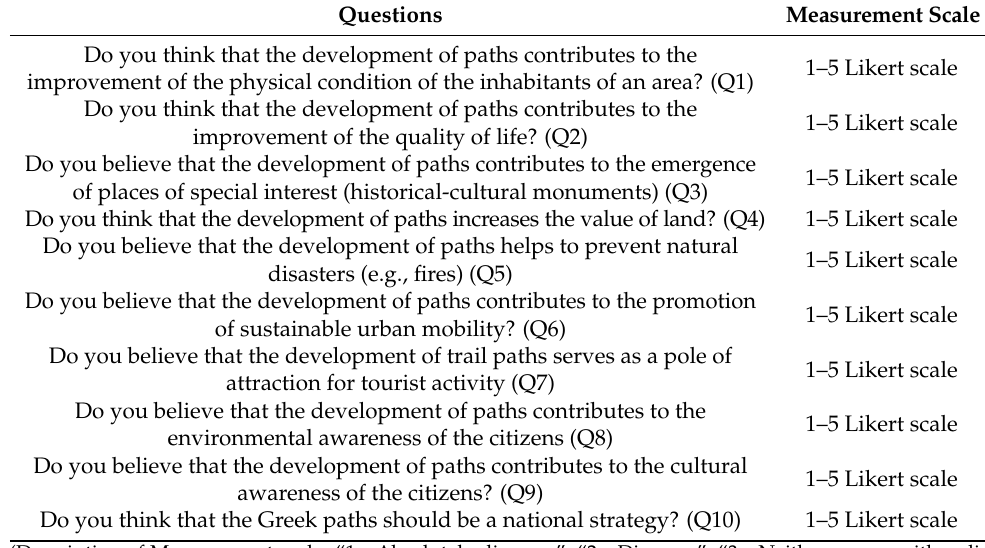
Table 1. Questions of the survey measured the attitudes of citizens towards trail paths. Questions Measurement